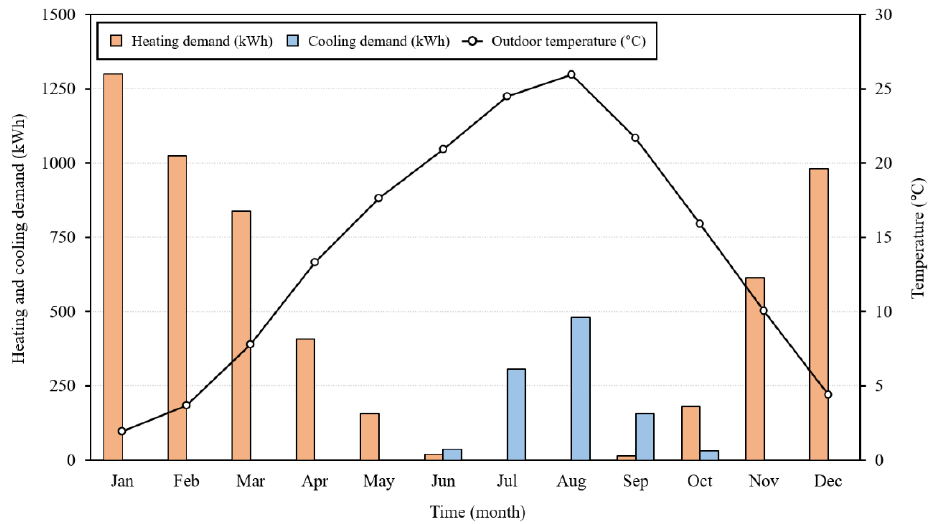
Figure 5. Monthly heating and cooling demand of the building load model.